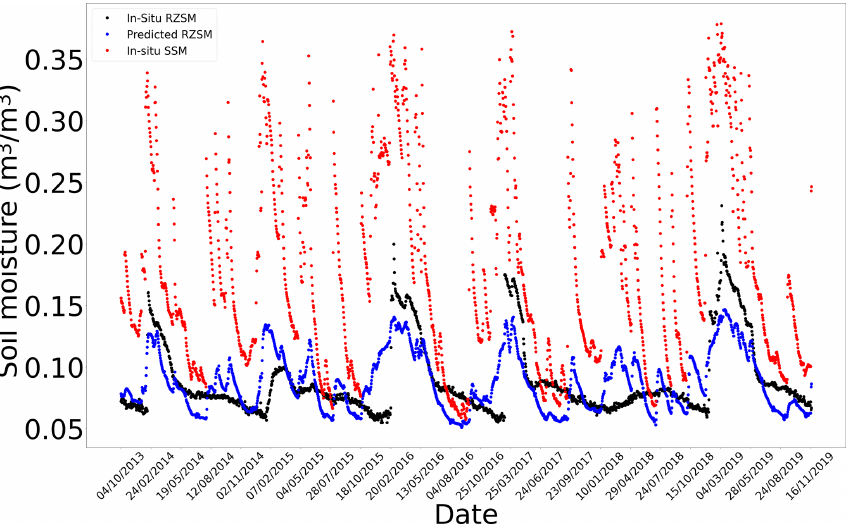
Figure E8. In situ SSM, in situ RZSM, and predicted RZSM series at station Nephi (SCAN) with model ANN_SSM_NDVI_EVAP-EFF-